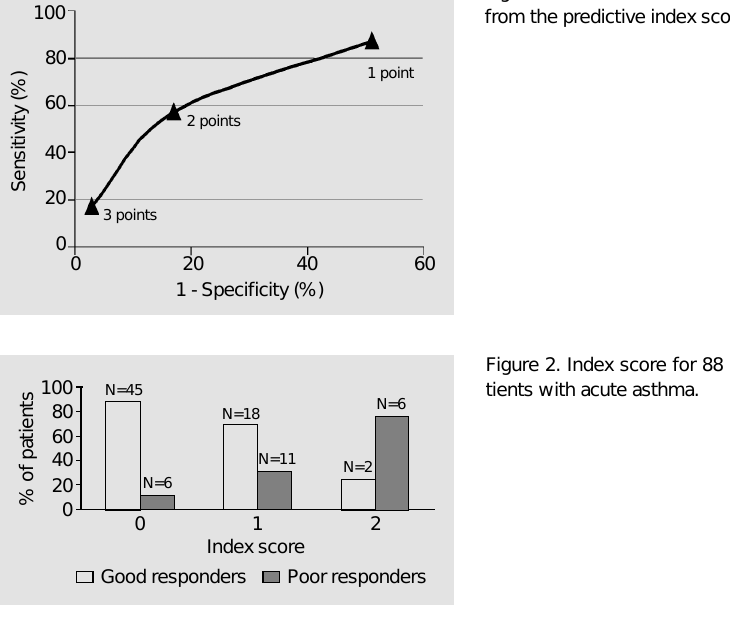
Figure 1. ROC curve obtained from the predictive index score.